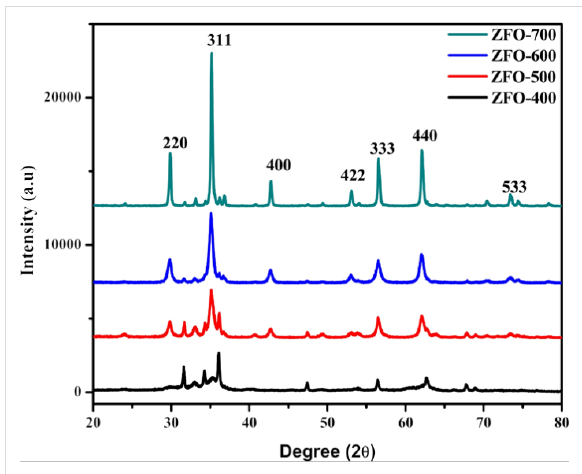
Figure 1: XRD patterns of ZFO samples with different calcination tem-